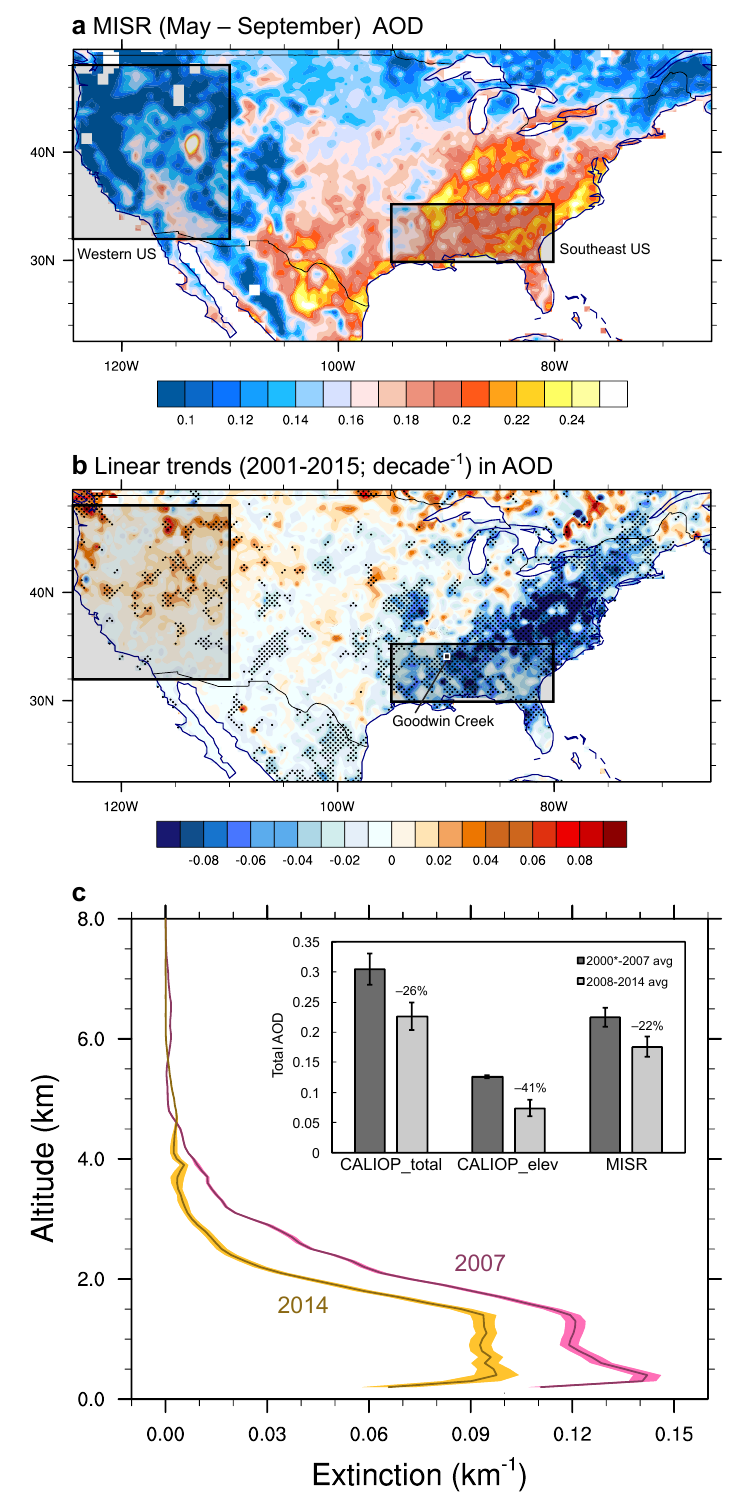
Figure 4. ( a ) summertime (May–September) aerosol optical depth (AOD) averaged for 2001–2015; ( b ) the linear trend (2001 to 2015) in summertime AOD. Aerosol data were taken from MISR (Multi-Angle Imaging Spectroradiometer) Stipling indicates statistically significant trends at 95% confidence; ( c ) main: vertical profiles of average summertime (May–September) aerosol extinction coefficients (km − 1 ) in the southeast US (SEUS) for both 2007 and 2014 calculated using CALIOP (Cloud Aerosol Lidar Orthogonal Polarization) lidar data. inset: summertime SEUS aerosol optical depth (AOD) averages for two periods (2000*–2007 and 2008–2014). CALIOP_total = total column AOD from the CALIOP instrument; CALIOP_elev = only elevated AOD (above the boundary layer) from the CALIOP instrument and MISR = MISR total column AOD. * For the two CALIOP variables: